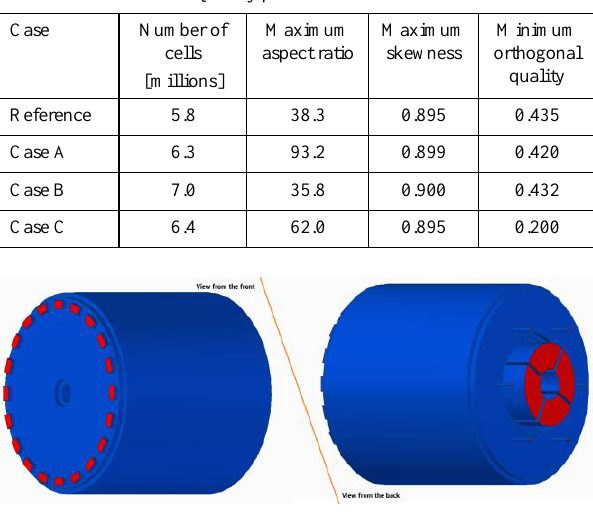
Fig. 4. Modified combustor (Case B)